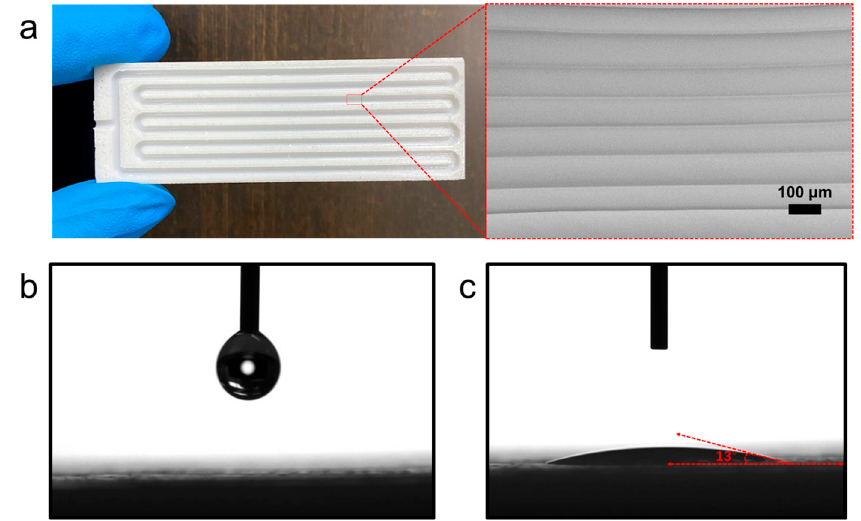
Figure 4. Photograph of ( a ) the internal serpentine flow channel structure of the FOHP and an ethanol droplet dropped ( b ) before and ( c ) after the inner surface.